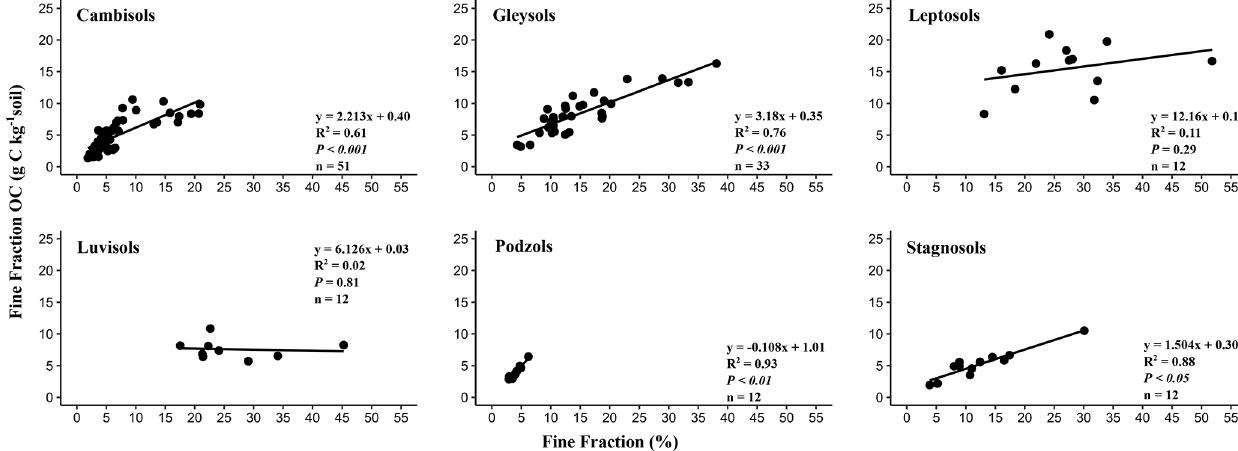
Figure 2. Relationships between mass proportion of the fine fraction (%) and fine-fraction organic carbon (gC per kg soil) in the soil types used in this